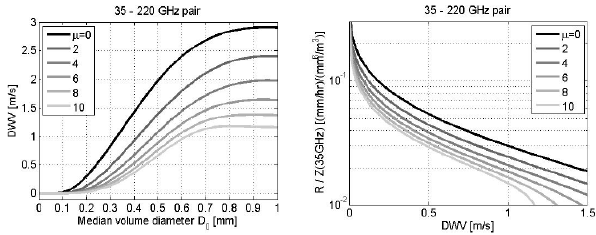
Figure 8. Left: dual-wavelength Doppler velocity as a function of the median volume drop diameter, D 0 , for the 35–220GHz pair. The different curves are the results of different shape parameters µ for a gamma DSD. Right: ratio of drizzle rate R to radar reflectiv- ity measured at 35GHz as a function of dual-wavelength Doppler velocity. Note that for 0 . 25 < DWV < 1m s − 1 an estimate of R/Z can be made to within ≈ ± 30% without knowledge of µ